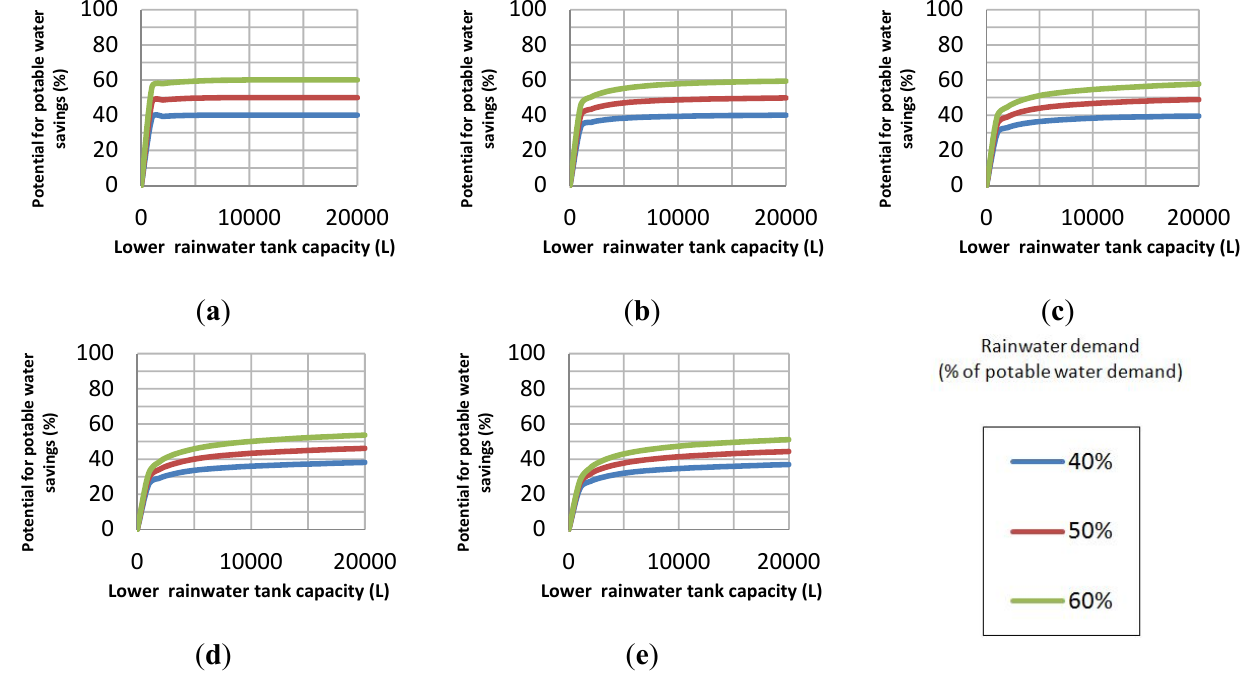
Figure 11. Potential for potable water savings as a function of lower rainwater tank capacity and potable water demand for Santarém, Brazil, for a catchment area of 400 m 2 and different potable water demands. ( a ) 100 L per house per day; ( b ) 300 L per house